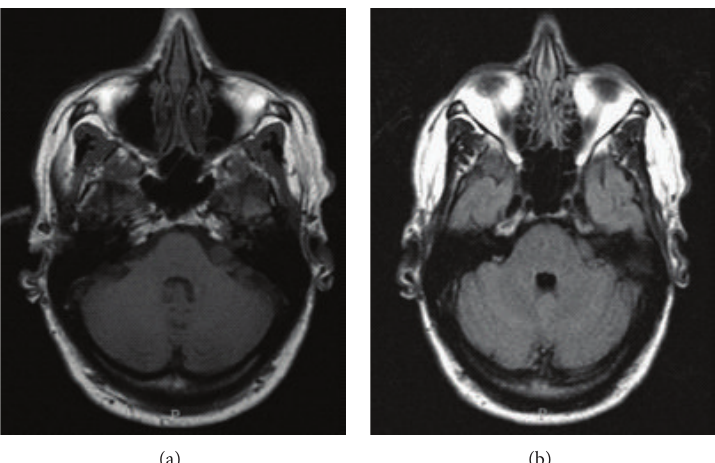
Figure 1: (a) T1-axial MRI with contrast and (b) T2-axial Flair MRI performed at initial encounter demonstrate a minimally enhancing mass in the left cerebellopontine angle.